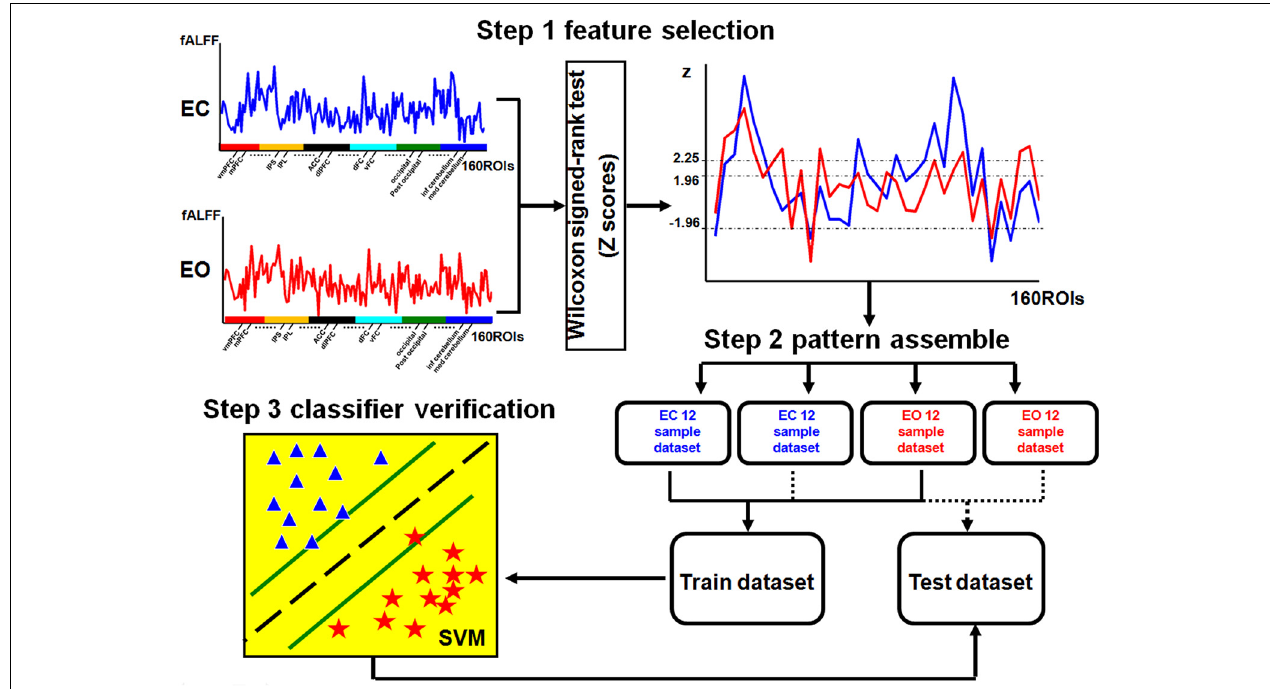
FIGURE 1 | Flowchart of MVPA. The fALFF values of 160 ROIs were used as the features. A nonparametric two-sample Wilcoxon signed-rank test was performed to detect discriminatory patterns between two conditions (EC and EO). The selected features from each of the 12 subjects for each condition were ranked as a sample dataset, which resulted in two sample datasets for each condition: one was used to